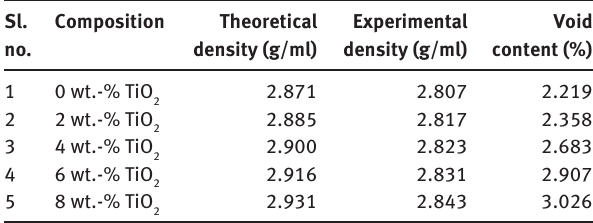
Table 2 Hardness of micro-TiO